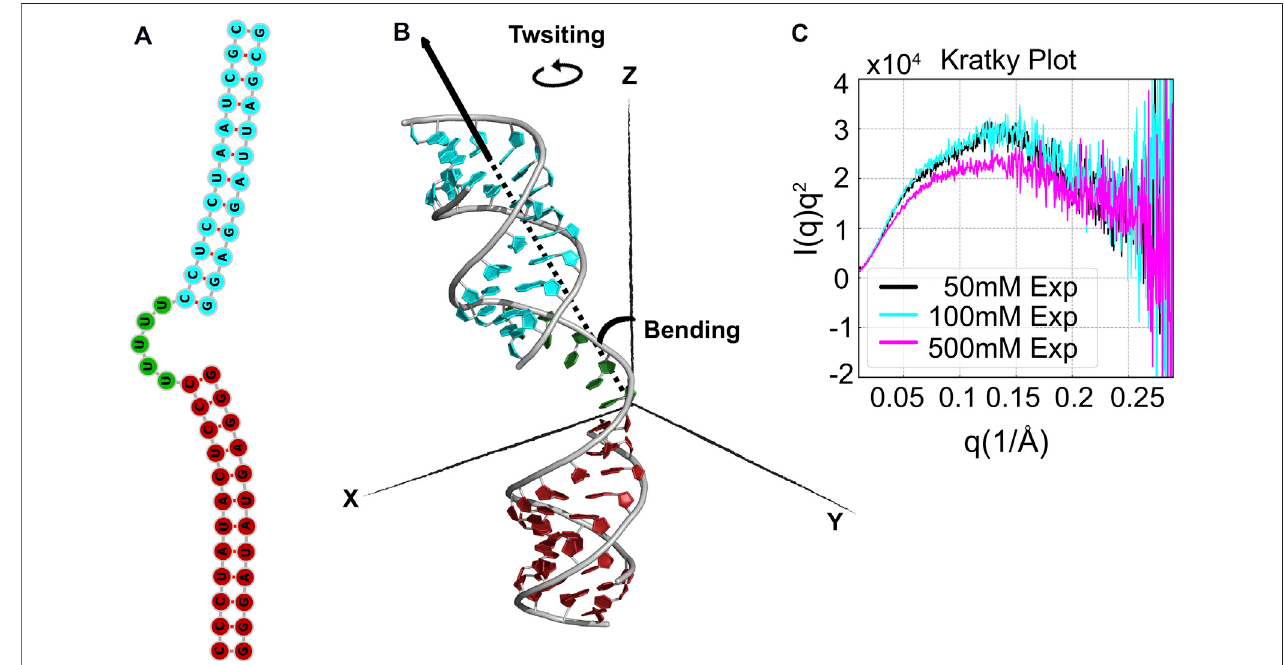
FIGURE 9 | Structure and sequence of RNA HJH. (A) The HJH molecule consists of three components: 12-bp duplexes that are connected by a rU 5 junction (green). (B) Thepositioningbetweenthebottomduplex(cyan)andtheupperduplex( fi rebrick)isusedtode fi nethetwoaxialvectorsmeasuringtwistingandbending. (C) SAXS data from experiments in low (50 mM), middle (100 mM), and high (500 mM) [KCl] shown as Kratky